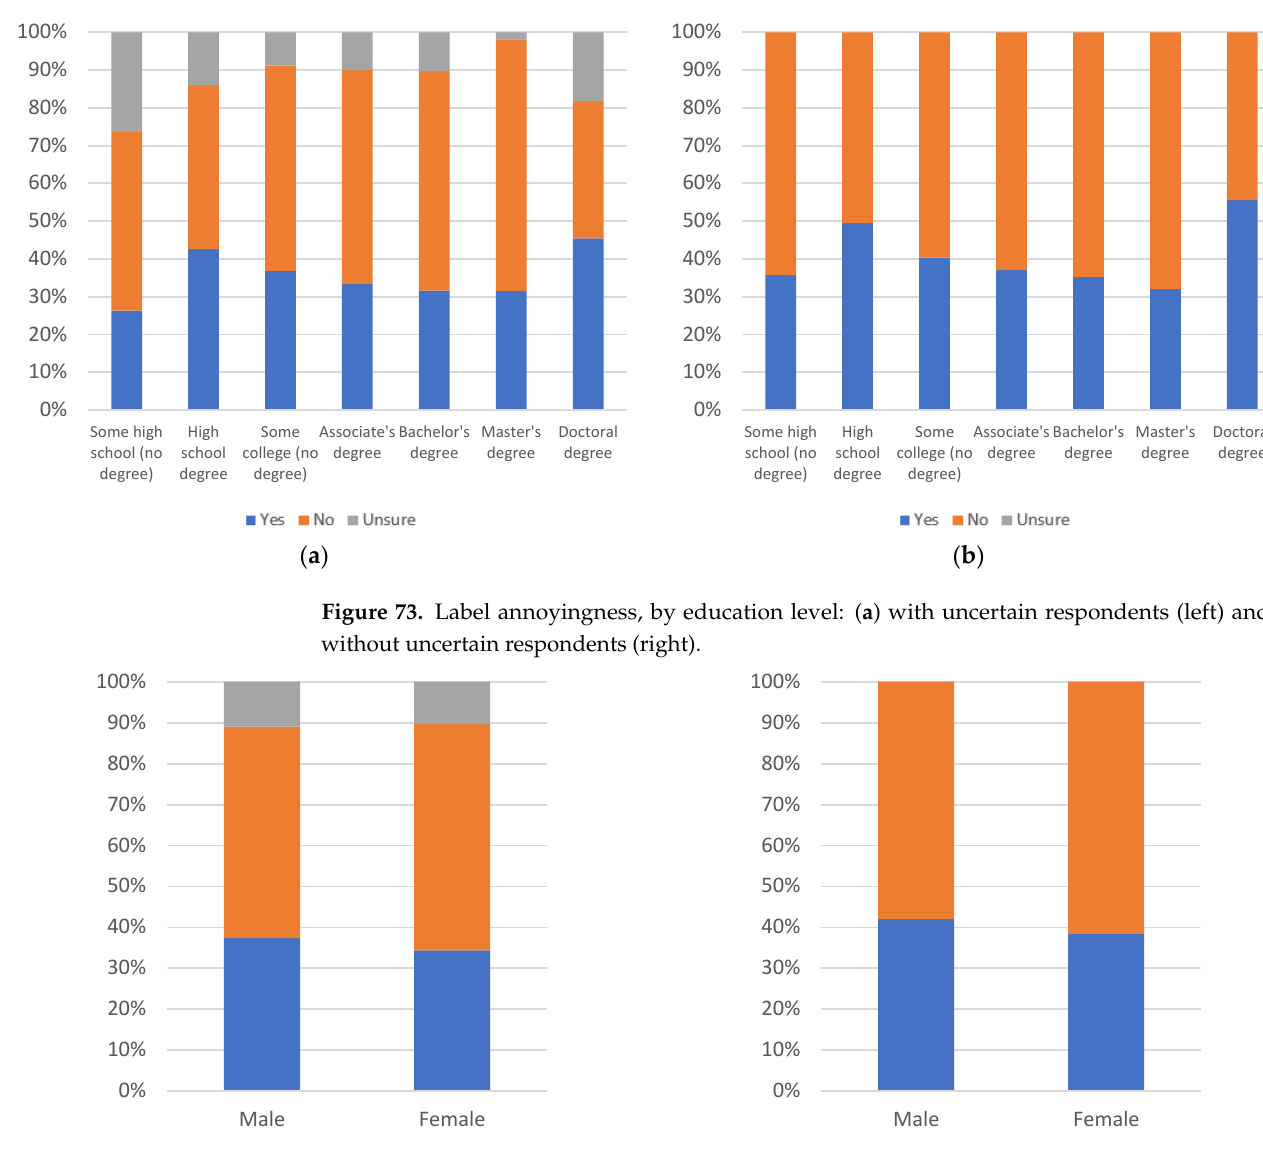
Figure 72. Label annoyingness, by age group: ( a ) with uncertain respondents (left) and ( b ) without uncertain respondents (right).